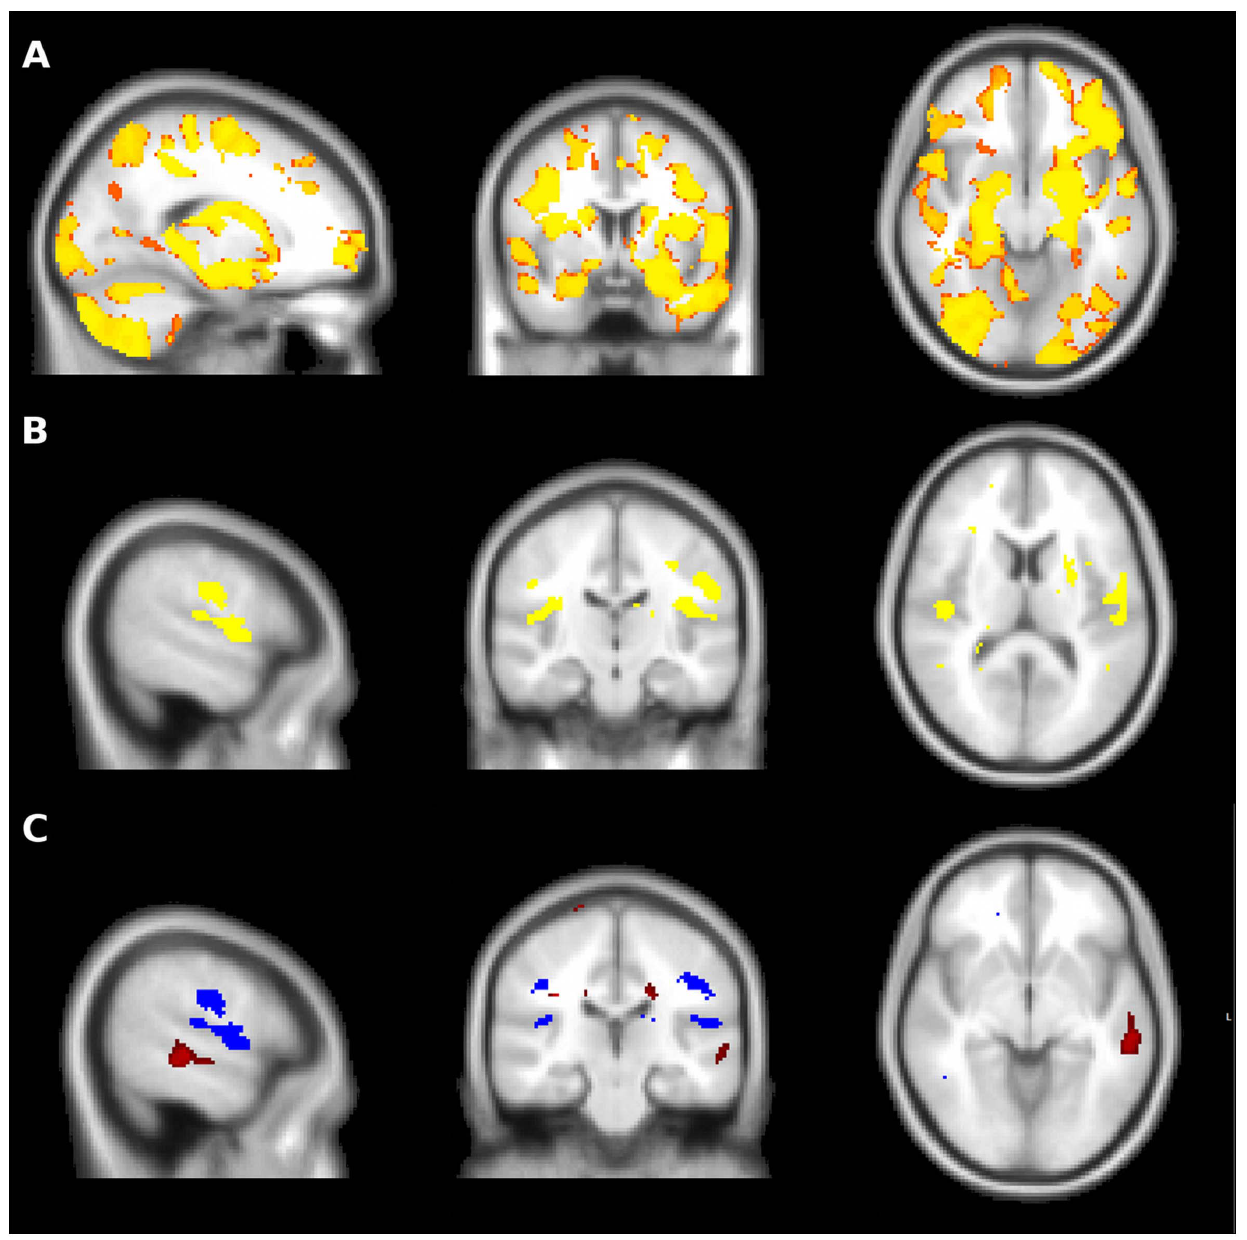
Figure 2. Voxel based morphometry in CBS patients. A – CBS patients demonstrated widespread cerebral atrophy compared to controls, with marked frontal, temporal, parietal and basal ganglia involvement. B – The PiB-positive and PiB-negative groups both demonstrated bilateral peri- insular and post-central gyrus atrophy, worse on the left than the right. C – In addition to peri-insular atrophy (blue), the PiB-positive group demonstrated atrophy of the posterior portion of the left superior temporal gyrus when compared to the PiB-negative group (red). In the inverse contrast, the PiB-negative group did not demonstrate greater atrophy than the PiB-positive group in any brain region.